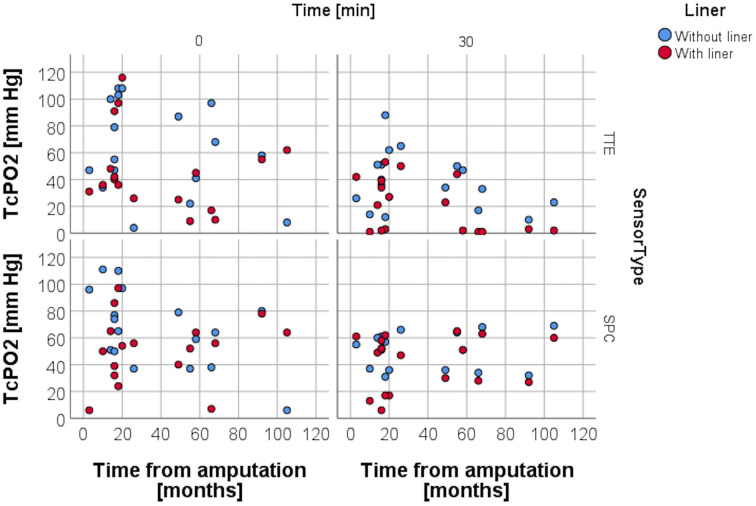
TcPO2 levels and time from amputation.Scattergram depicting distribution of TcPO2 levels with and without liner wear depending on the time from amputation.